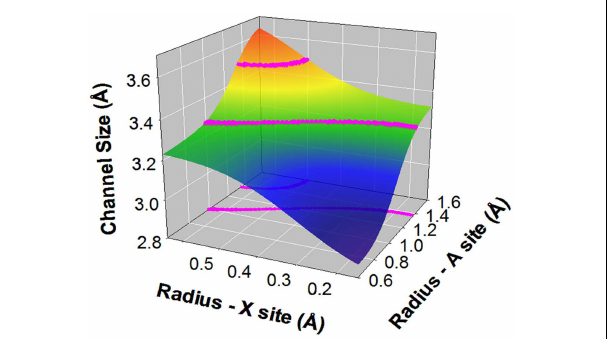
FIGURE 8 | Prediction of unknown apatite compositions with iodide ion in the structural channel. The region between pink lines is possible average radii of A and X cations. The two pink lines define channel size that fits iodide in the structure, which is calculated based on ionic radius of iodide 2.20Å and 3.5% error prediction. The region is also both projected on to the radius –A and radius-X plane and on to the surface of predicted channel size.